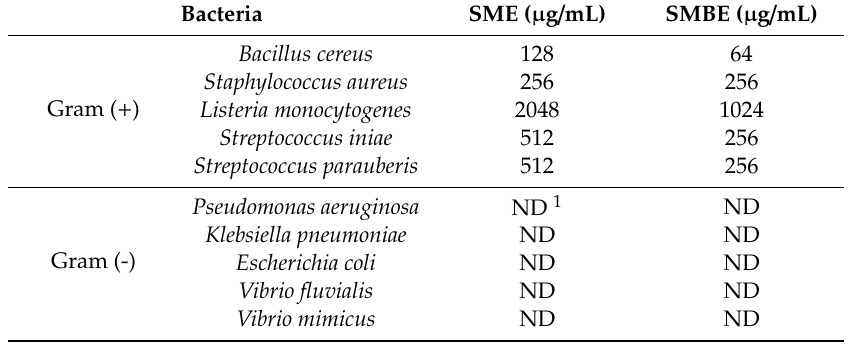
Table 3. Minimum inhibitory concentration (MIC) values of SME and SMBE against various pathogens.